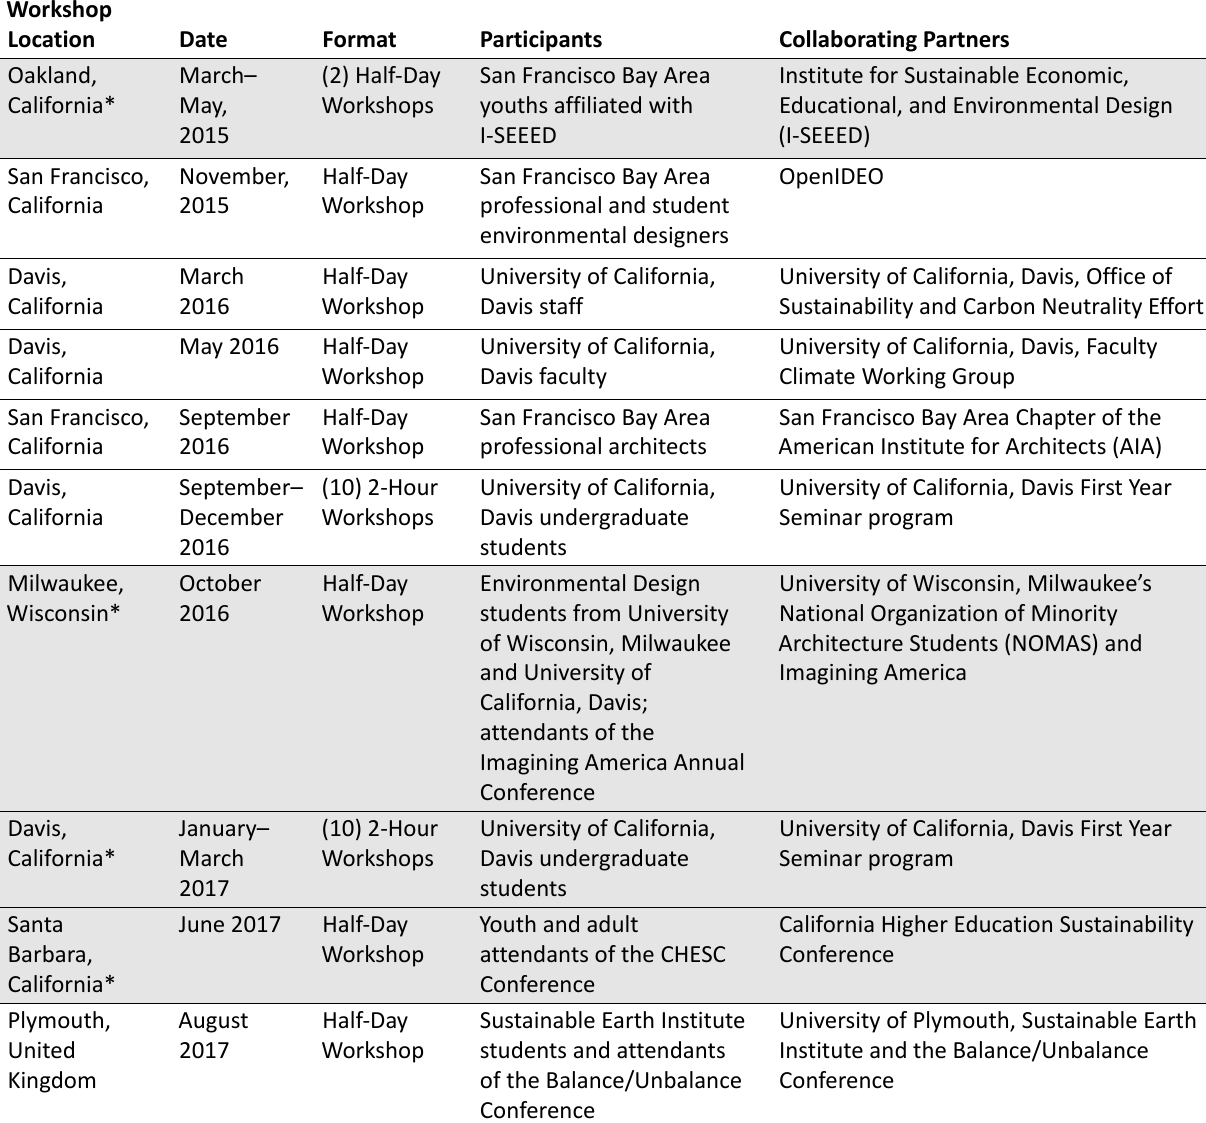
Table 1. #OurChangingClimate workshop locations, dates, formats, and collaborating partners.